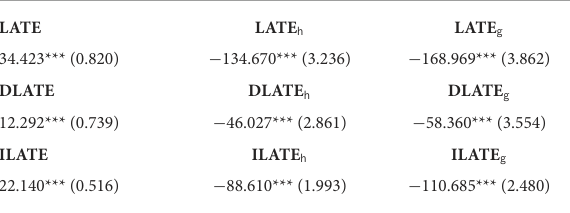
TABLE 6 Productivity, efficiency and welfare estimates on soybean yield—(lnKg/ha). Impact on: welfare Technology frontier Inefficiency frontier